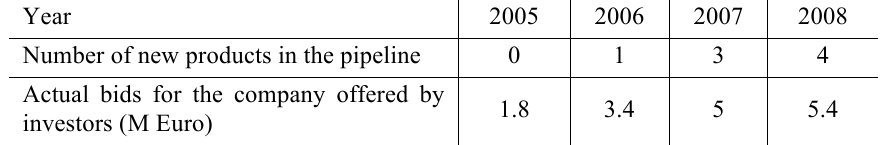
Table 1 . Dependence between number of products under development and company value (own research) Year Number of new products in the